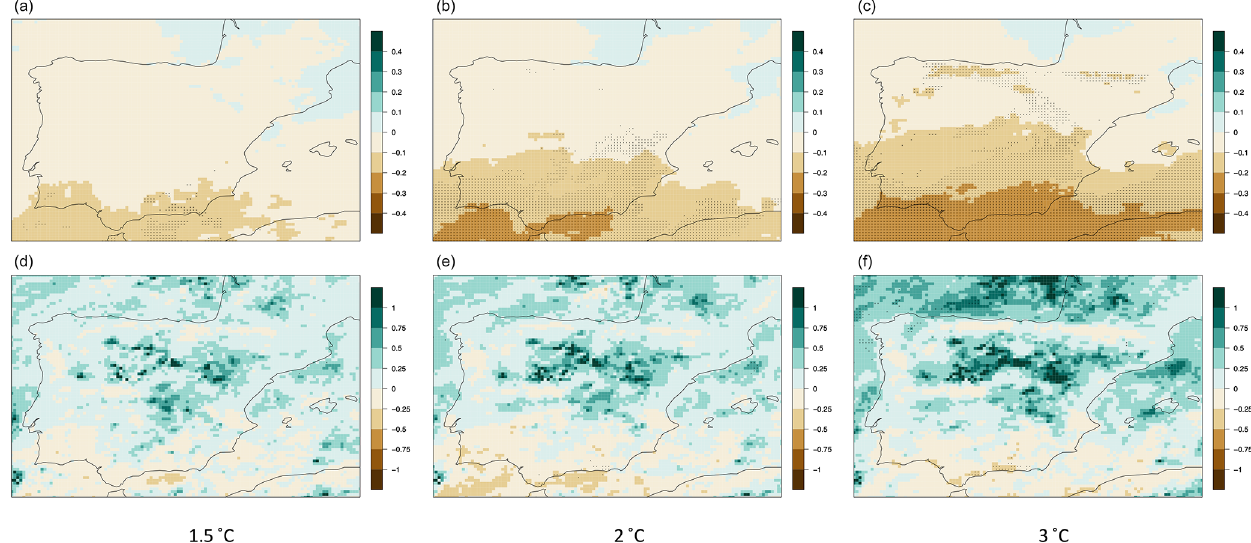
Figure 6. Ensemble mean of the relative changes of total annual precipitation (a–c) and number of days with daily precipitation more than 40mm (d–f) for 1.5, 2 and 3 ◦ C global warming levels (columns) at annual scale. Dotted areas indicate where at least 50% of the simulations show a statistically significant change and more than 66% agree on the direction of the change. Coloured areas (without dots) indicate that changes are small compared to natural variations, and white regions (if any) indicate that no agreement between the simulations is found (similar to Tebaldi et al., 2011).